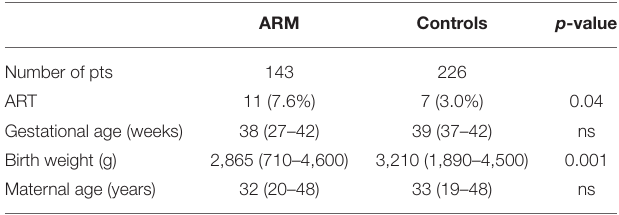
TABLE 1 | Comparison between anorectal malformation (ARM) population and controls.